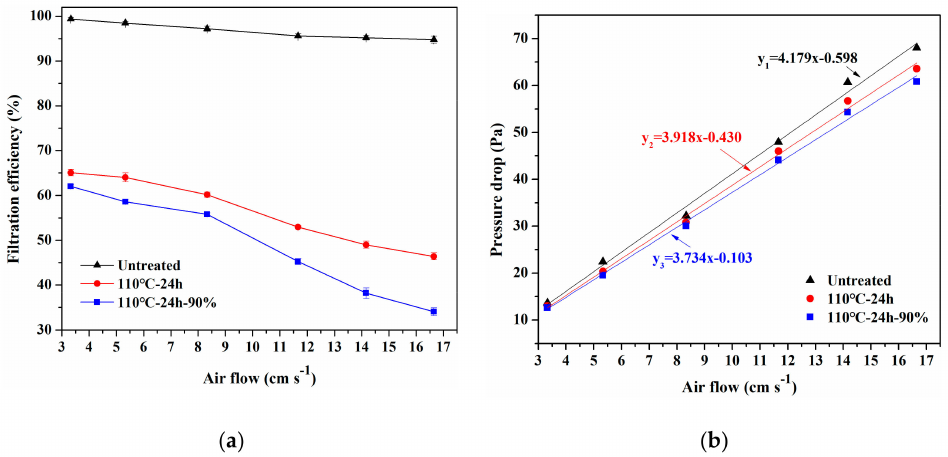
Figure 6. Filtration performance of melt-blown nonwovens after di ff erent heat treatment: ( a ) Filtration E ffi ciency (FE) and ( b ) pressure drop versus various airflow